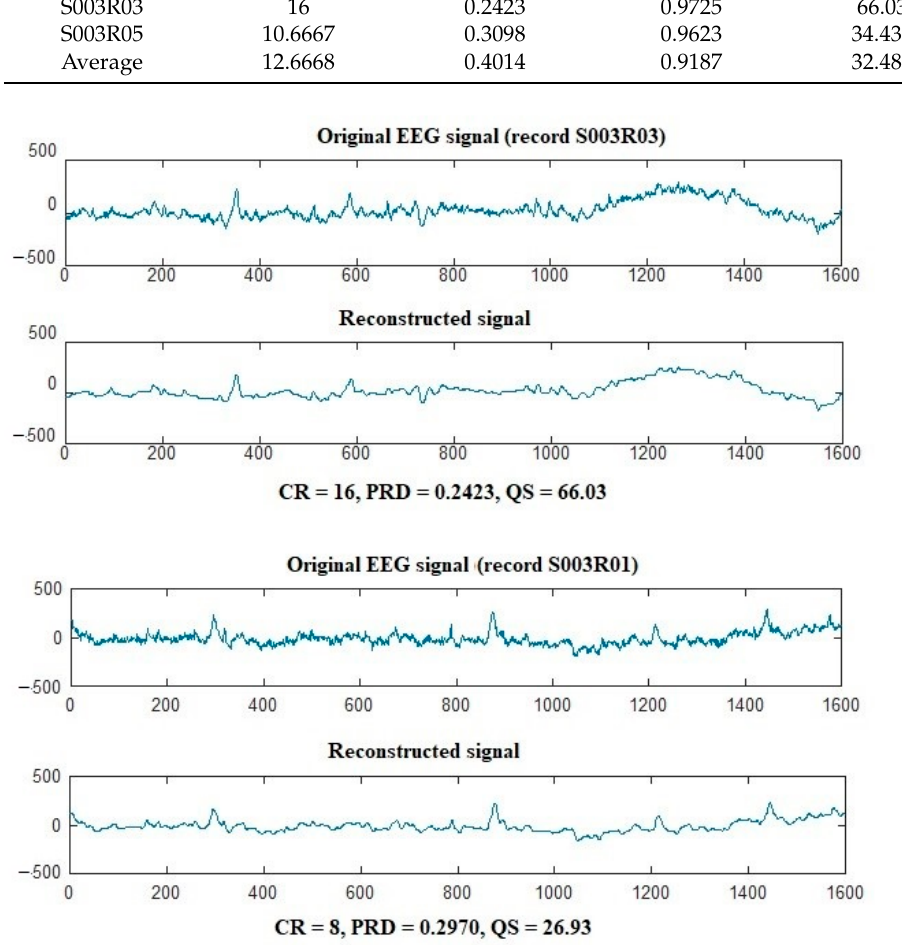
Figure 5. Compression of S003R03 and S003R01 EEG records using the proposed algorithm. Table 4. Processing time of the proposed and existing techniques in seconds for ECG compression.